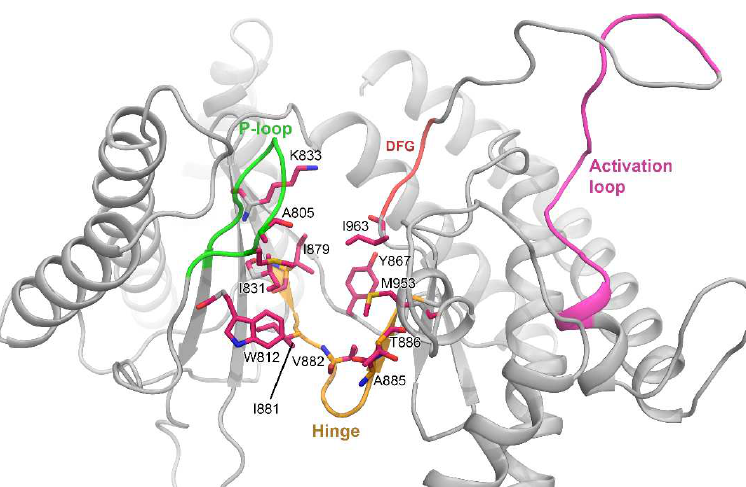
Figure 3. Per-residue MM-PB/GBSA binding free energy decomposition analysis. Common residues within the 4 Å of ligand atoms that contributed the binding energy to final ΔTOTAL terms are shown in stick representation. The different subdomains, such as the P-loop, Hinge, DFG motif, and activation loop, are colored in green, yellow, red, and